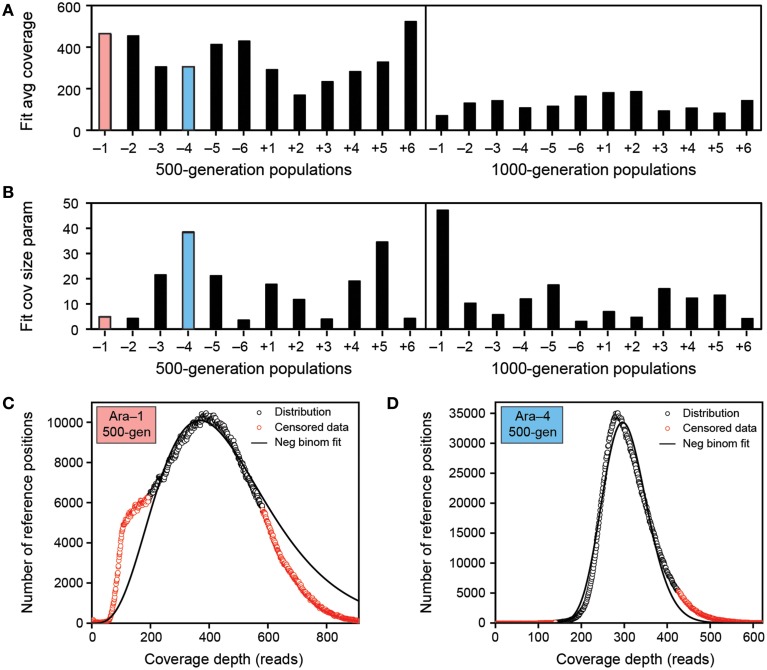
Characteristics of the LTEE population sequencing data sets. (A) Negative binomial fits to the distributions of read-depth coverage across the ancestral reference genome show that the average coverage was higher by a factor of approximately three in the 500-generations samples compared to the 1000-generation samples. (B) The uniformity of read-depth coverage across the reference genome varied greatly across these samples. This characteristic of the negative binomial distribution is captured by the size parameter (r) where lower values mean greater overdispersion relative to an idealized Poisson distribution in which there is an equal probability of reads being represented from all parts of the reference genome. (C) Negative binomial fit to the coverage distribution of population Ara-1 at 500 generations. This data set has a relatively large variance (small r size parameter of ~5), and it also has a distinct shoulder of many positions with lower-than-expected coverage values that is not fit well by this model. As described elsewhere, red values are censored during the fitting procedure to reduce the effect of potential outliers (Barrick et al., 2014). (D) Negative binomial fit to the coverage distribution of population Ara-4 at 500 generations. This data set has a relatively small variance (larger r size parameter of ~40) and yields a much better fit to the coverage read-depth model.